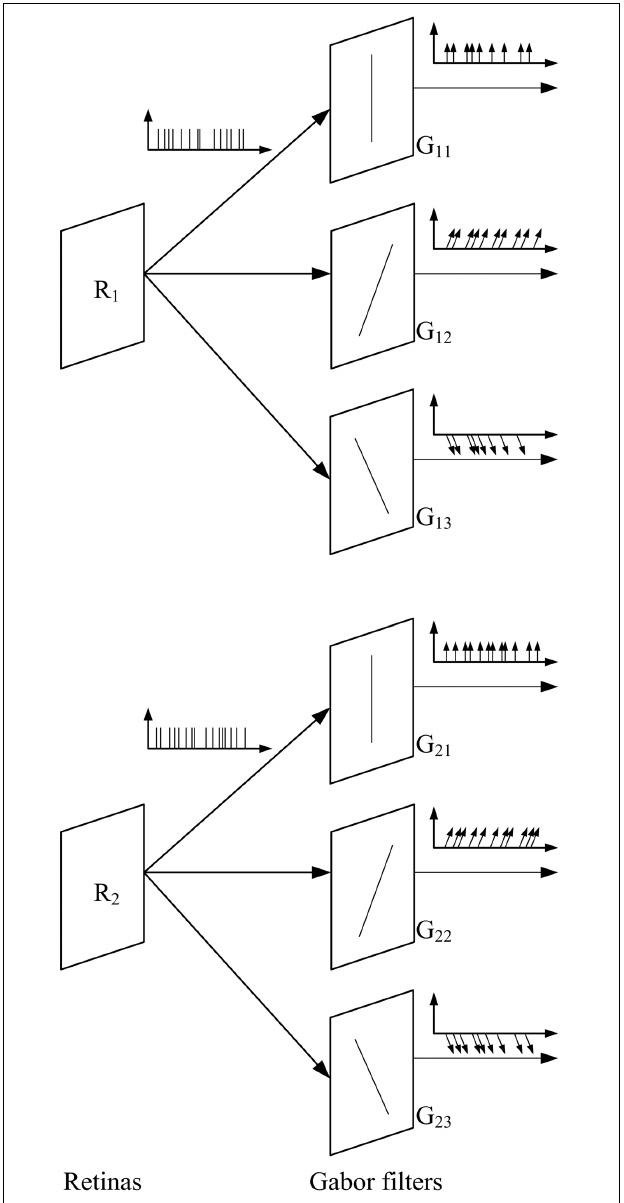
FIGURE 4 | Illustration of the use of 3 Gabor filters with different orientations to the output of both retinas. The events generated by the filters carry additional information, as they represent the orientation of the